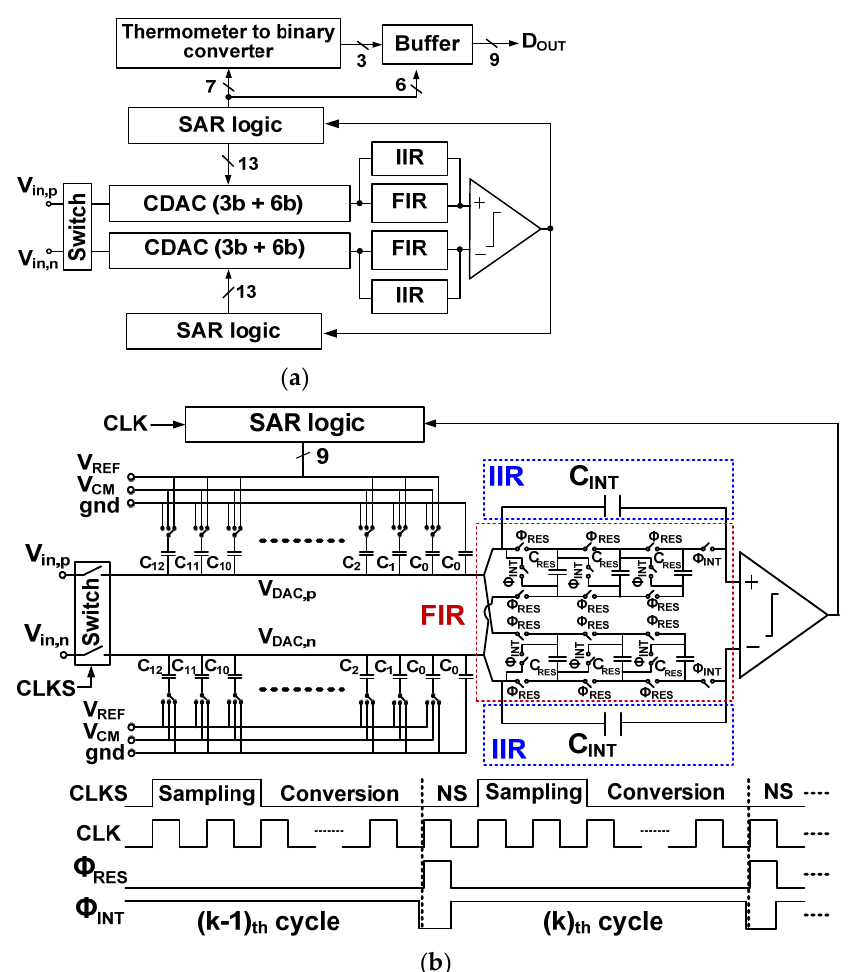
Figure 2. ( a ) Block diagram of the proposed ADC; ( b ) schematic of the proposed noise-shaping SAR ADC with timing waveforms. The V REF = 1.8 V is the reference voltage.